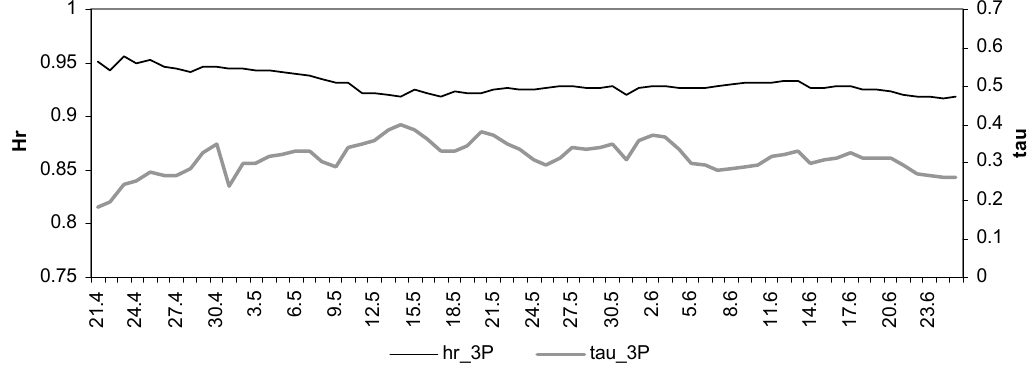
Figure 13. Development of retrieved vegetation optical depth (tau_3P) and roughness parameter H r